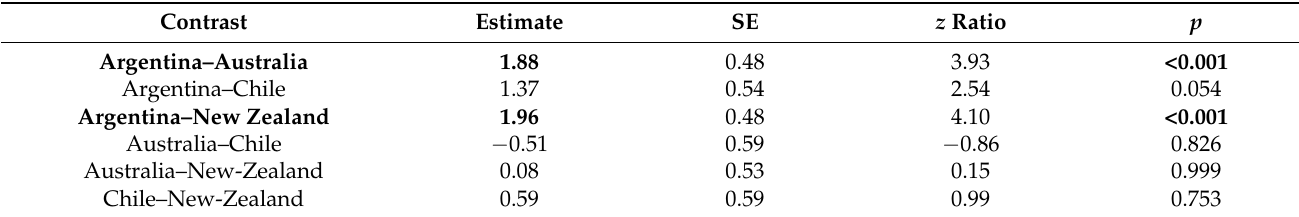
Table A3. Post host comparisons between geographic regions on the total number of locations from which galaxiid–parasite associations have been studied. Statistically significant estimates ( α = 0.05) are in